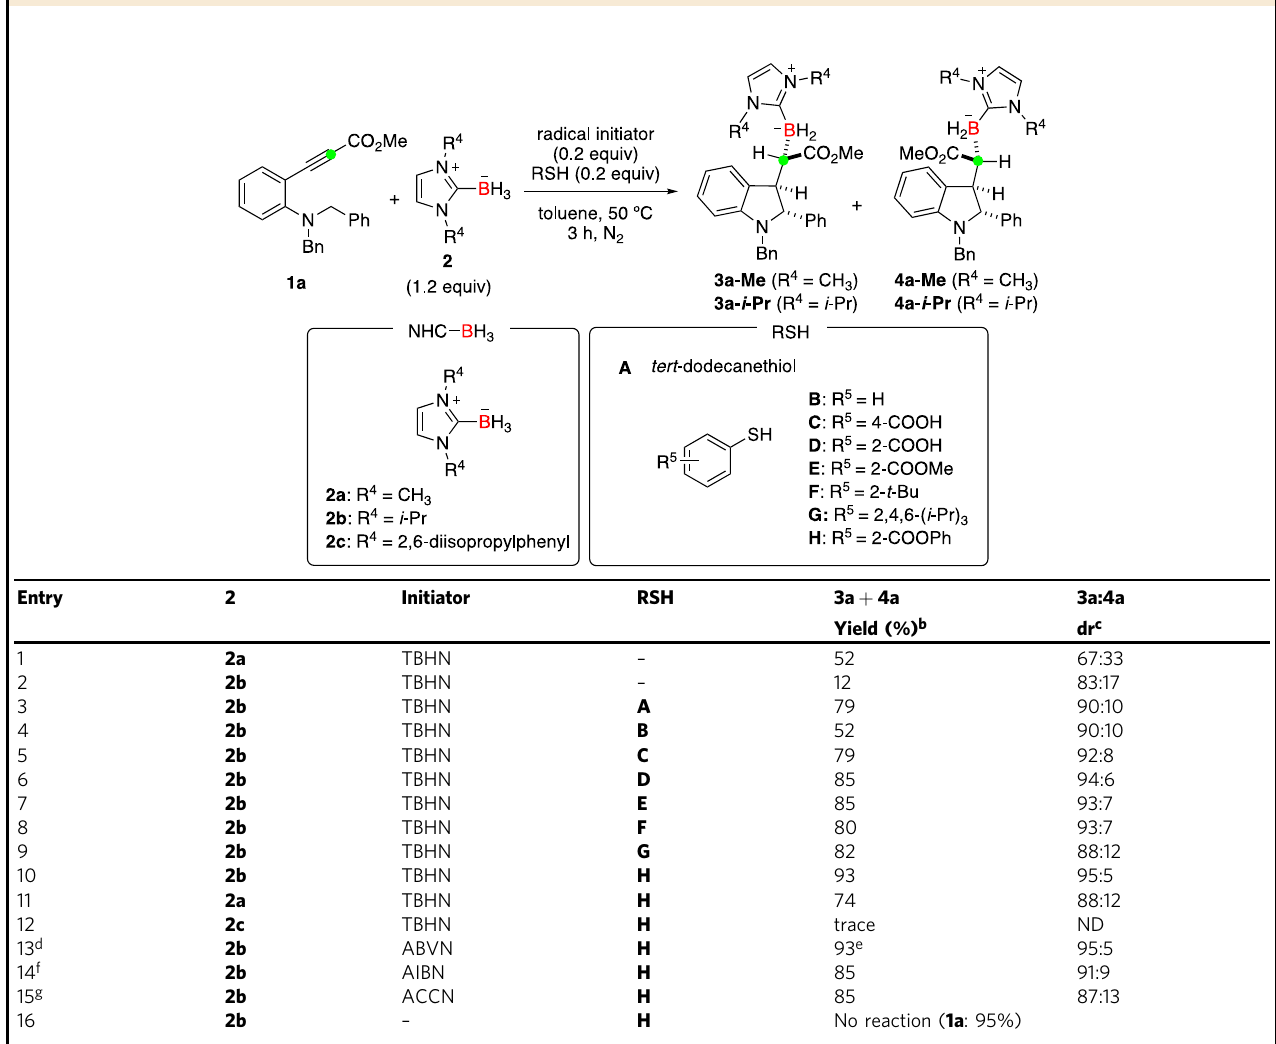
Table 1 Optimization of the reaction conditions a